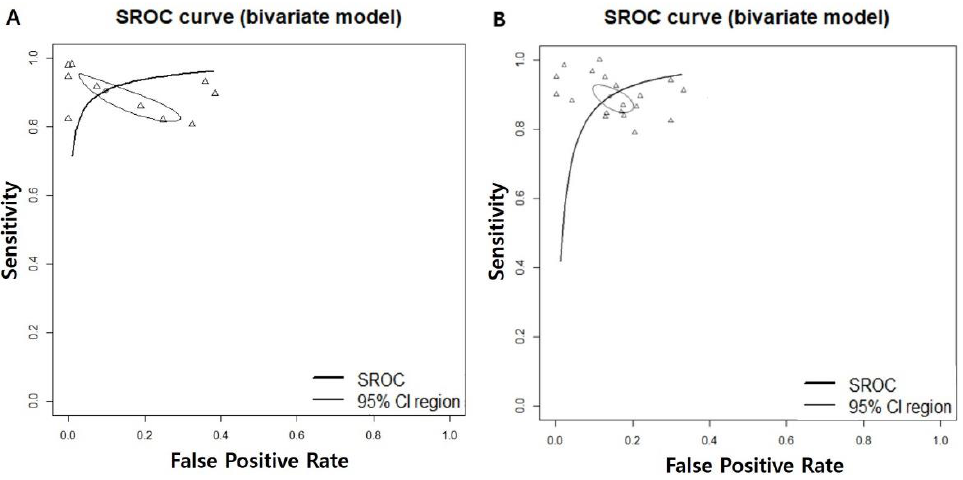
Figure 3. Area under the summary receiver operating characteristic for ( A ) screening only the oral cancerous lesions and ( B ) screening all premalignant mucosal lesions. SROC; summary receiver operating characteristic, CI; confidence interval.